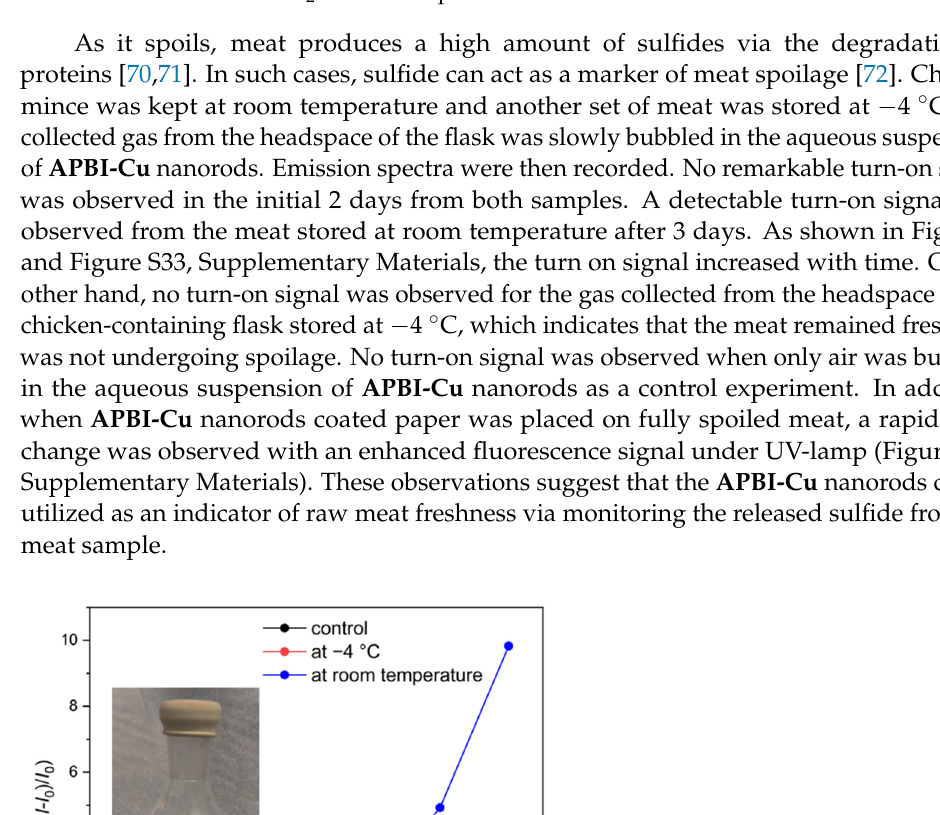
Figure 6. Digital images of paper strips coated with APBI-Cu under UV-lamp after the treatment of various concentrations of Na 2 S made in tap water.